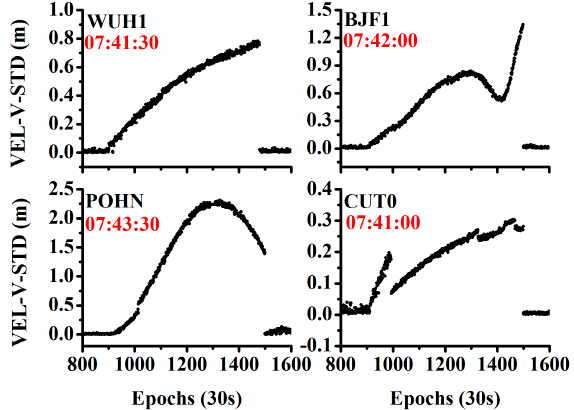
Figure 8. Time series of the STD of the observation residuals for different stations on July 18, 2016.